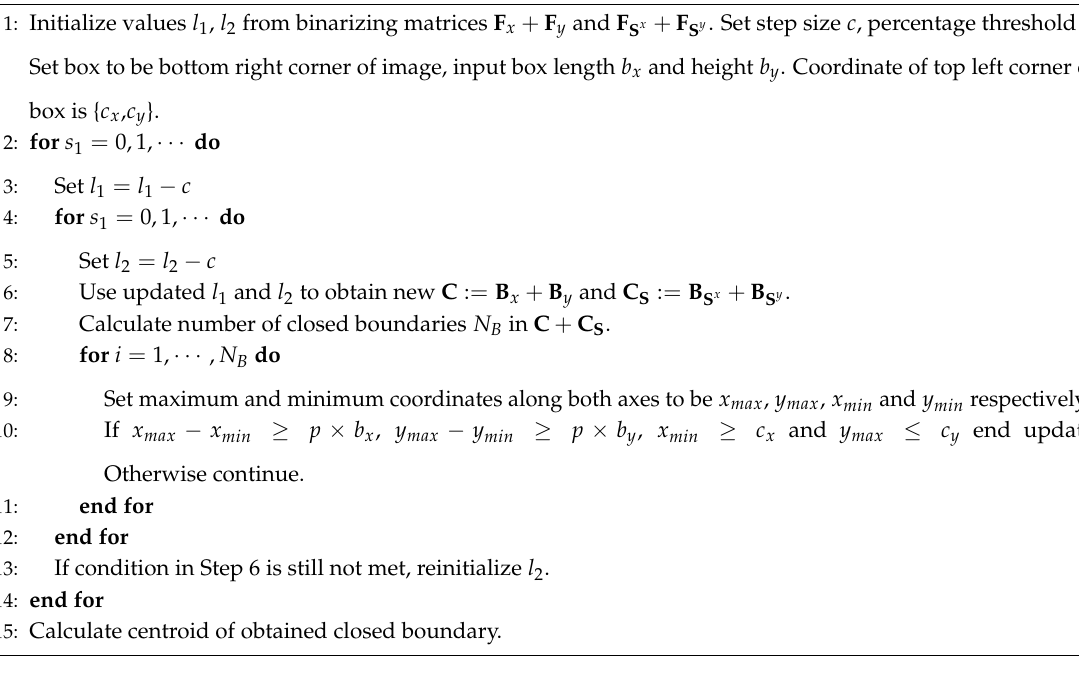
Algorithm 1 Recursive Estimation of the Closed Boundary of the Left Atrium